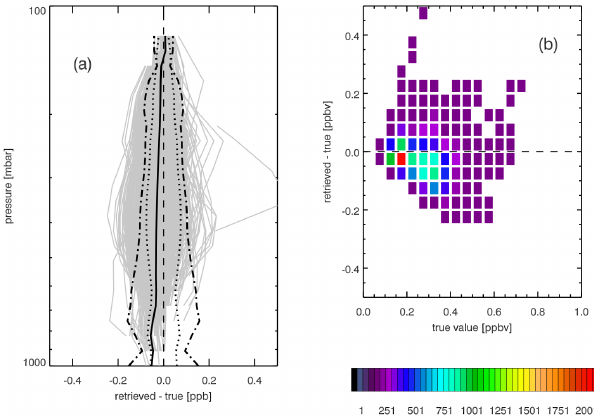
Figure 7. (a) Differences between retrieved and true PAN profiles for the simulated dataset (after application of the averaging kernel and prior to the true profiles). The solid line shows the mean difference. Dotted and dot-dashed lines show the RMS difference for (retrieved-true) and (prior-true) respectively. (b) Two-dimensional histogram of differences between the retrieved and true PAN values as a function of the true values. Plots show only profiles for which the maximum value in the true profile was greater than 0.2 and only points where the sum of the row of the averaging kernel is greater than 0.5 are shown. Color bar for (b) shows the number of points in each histogram bin.